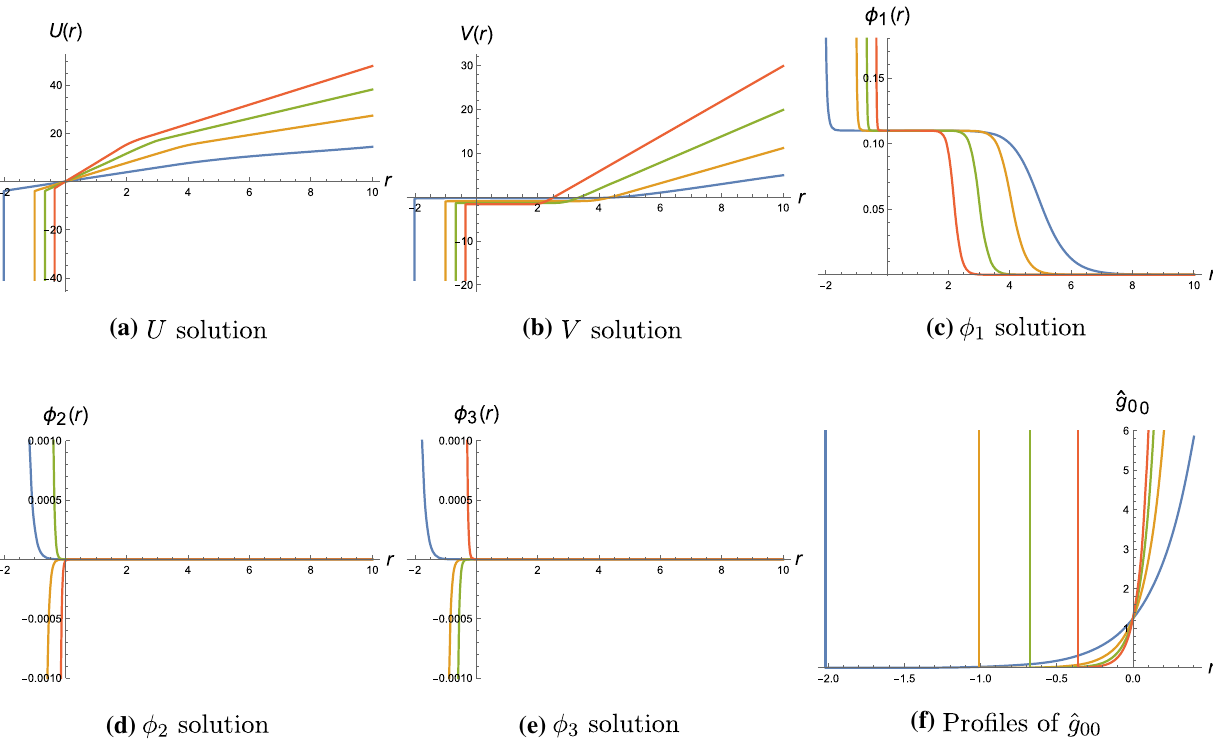
Fig. 23 RG flows from the N = 4 AdS 7 critical point to the AdS 3 × CH 2 fixed point and curved domain walls with φ 1 , φ 2 and φ 3 non-vanishing for SO ( 3 ) ∼ SU ( 2 ) twist in SO ( 5 ) gauge group. The blue, orange, green and red curves refer to g = 8 , 16 , 24 , 32, respectively